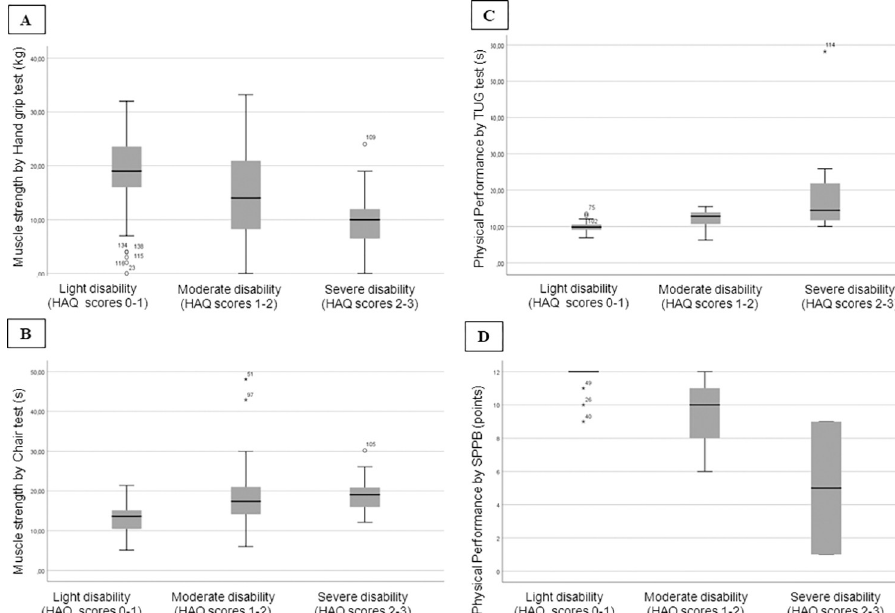
Fig 5. A. Mean and SD of muscle strength by handgrip test stratified by disability status of HAQ-DI. B. Median and (IQR) of muscle strength by chair test stratified by disability status of HAQ-DI. C. Median and (IQR) of physical performance by Timed up and go (TUG) test stratified by disability status of HAQ-DI. D. Median and (IQR) of physical performance by The Short Physical Performance (SPPB) test stratified by disability status of HAQ-DI. Independent Samples Kruskal-Wallis test for all analysis.